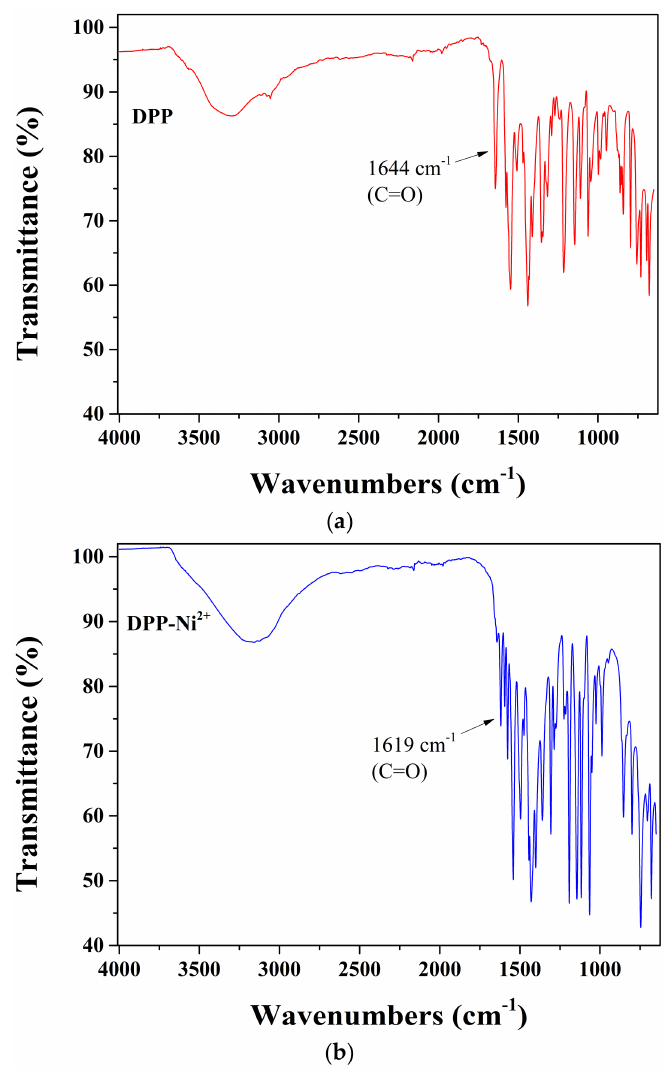
Figure 6. FT − IR spectra of ( a ) DPP and ( b ) DPP -Ni 2+ . With the outcomes of Job plot, ESI-mass, and IR analysis, the possible feature of DPP with Ni 2+ was proposed (Scheme 1).